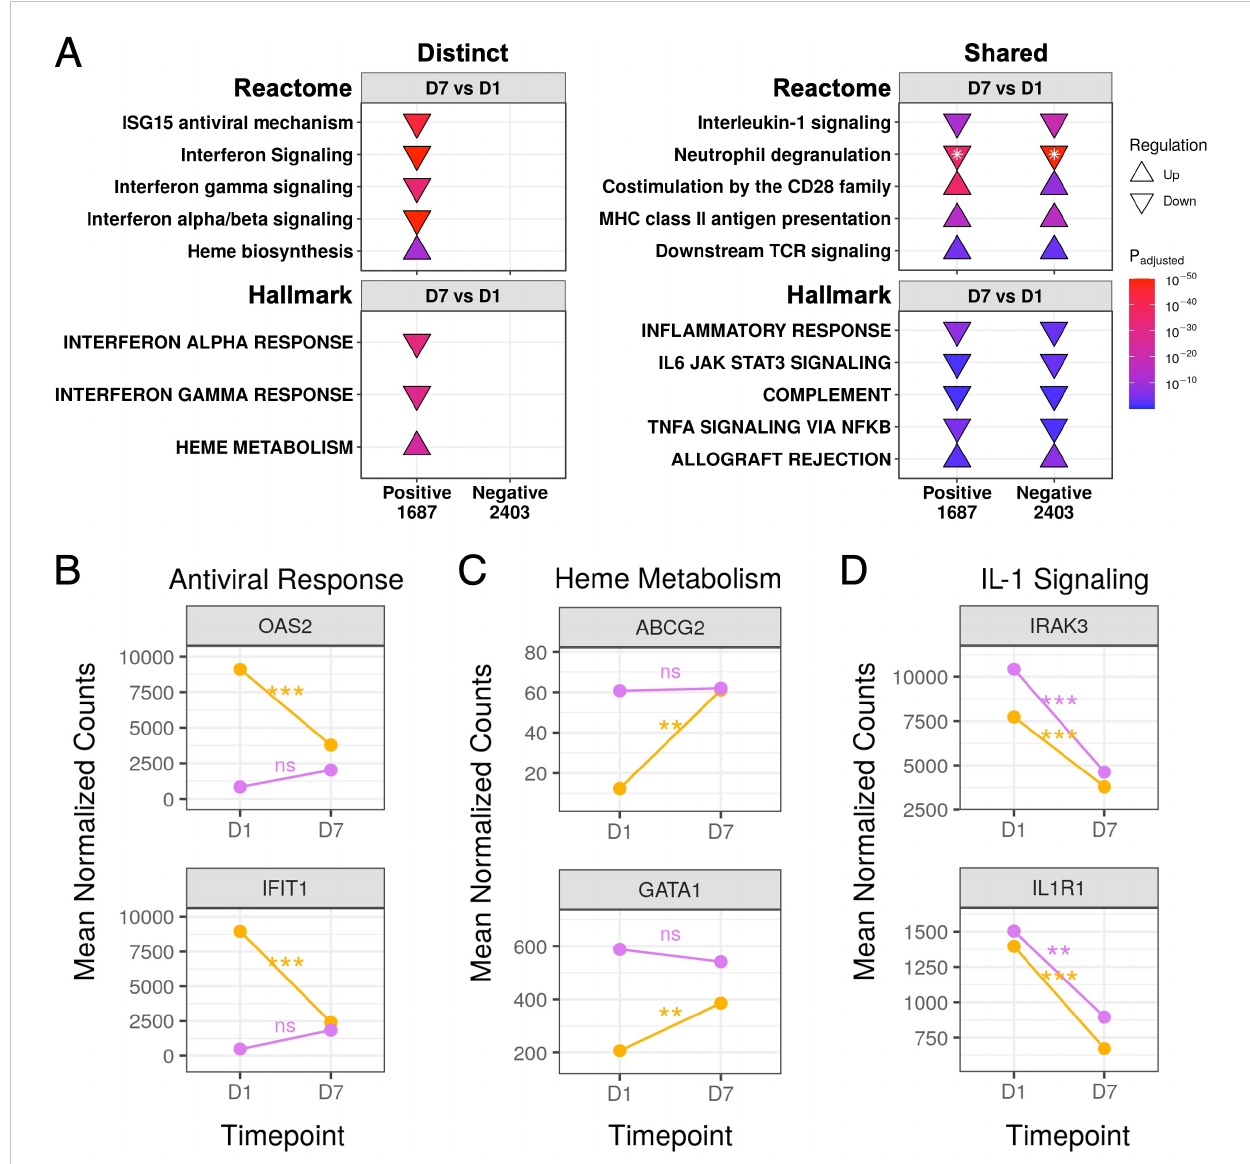
FIGURE 5 Gene expression trajectories of distinct and shared DE genes in COVID-19 and non-COVID-19 sepsis patients over time. (A) Subset of the enriched Reactome pathways (top) and Hallmark gene sets (bottom) using DE genes over time in COVID-19 (Positive) and non-COVID-19 sepsis (Negative) patients, separated into distinct (left) and shared (right) enriched pathways. The full list of enriched pathways/gene sets is shown in Figures S4, S5. “ Upregulated ” pathways/gene sets ( D ) had genes that were overrepresented in upregulated DE genes when compared to their prevalence in the genome, suggesting an increase in their function or activity, and vice versa for “ downregulated ” pathways/gene sets ( ∇ ). The total numbers of DE genes in each comparison are shown under each label. For one pathway, both up- and down- regulated genes were enriched (indicated by *); the direction with the lower adjusted p-value (more signi fi cantly enriched) is shown. The lower panels show mean DESeq2 normalized counts for representative genes involved in the antiviral response (B) , heme metabolism (C) , and interleukin-1 signaling (D) . Lines are coloured as yellow = SARS-CoV-2 positive, purple = SARS-CoV-2 negative. Genes in the antiviral response and heme metabolism signi fi cantly changed over time in COVID-19 patients but not in non-COVID-19 sepsis patients, while genes in interleukin-1 signaling signi fi cantly decreased over time in both patient groups. Statistically signi fi cant differences in panels B-D are indicated as ***p<0.001, **p<0.01, and *p<0.05; signi fi cance values were derived from DESeq2 model results. ns, not signi fi